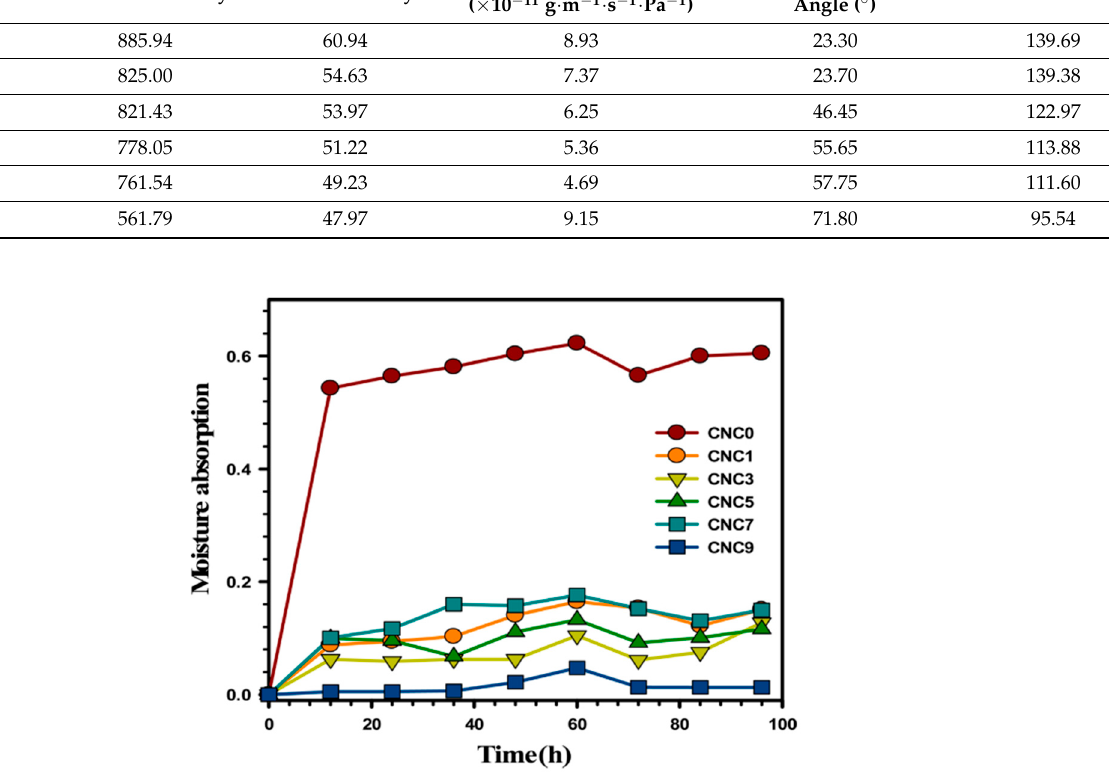
Figure 5. Trends in the moisture absorption of the kappa-carrageenan/nanocellulose composites at di ff erent loading (taken from [36] with permission from Elsevier).